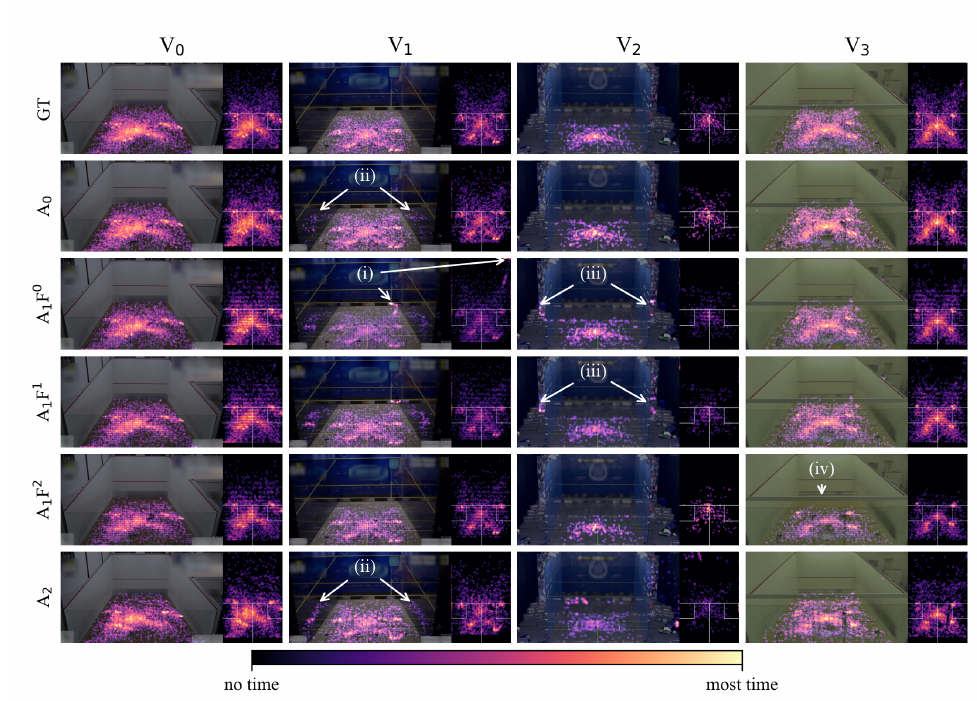
Figure 8. Heatmap visualization reveals differences between HPE-CNN detections and ground truth labels. Each column shows one video V 0 –V 3 . The first row depicts the ground truth obtained from labels. Rows 2–6 show detection results for every HPE-CNN evaluated on every video. Heatmaps show labels, and the respective detections for both players. False detections (i)–(iii) result in color differences with respect to the same location in the ground truth heatmap. Reflections of players (ii) and audience (iii) are challenges, specific to glass courts. For A 1 F 2 , the support beam in video V 3 disrupts detections.